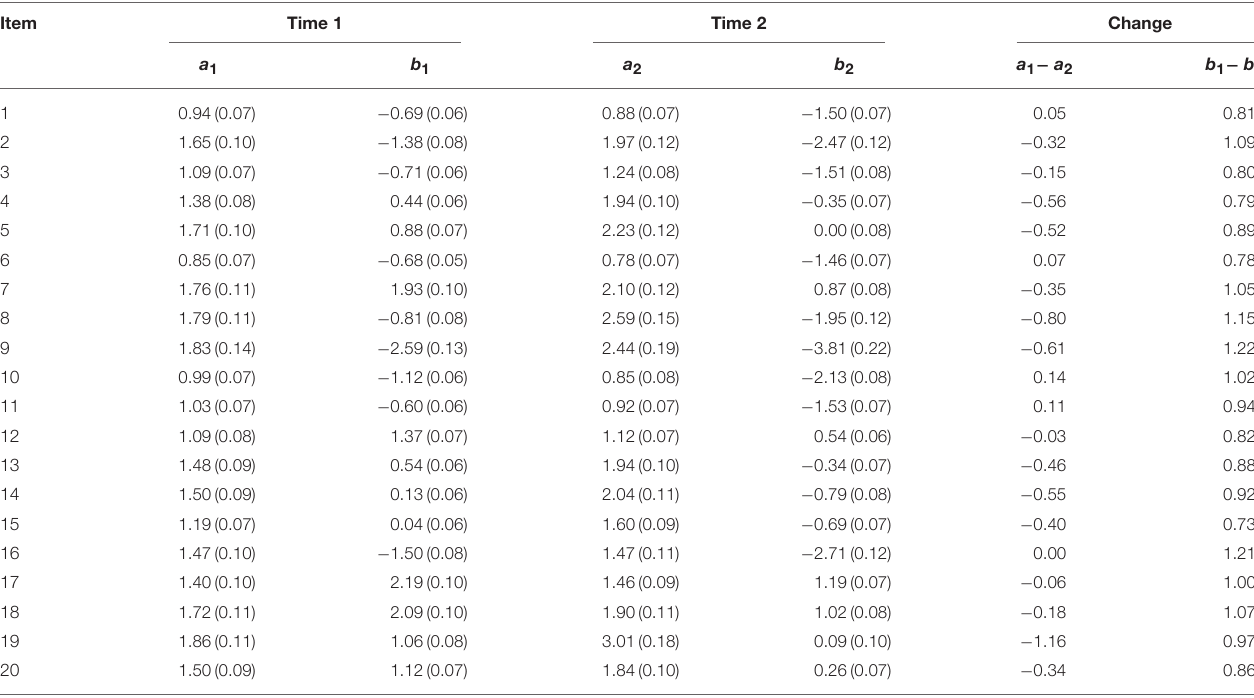
TABLE 9 | Fitting data generated from mixture IRT to unidimensional 2PL IRT model: Condition 4 [change in ability distribution for Group 1 at Time 2 to θ ∼ N